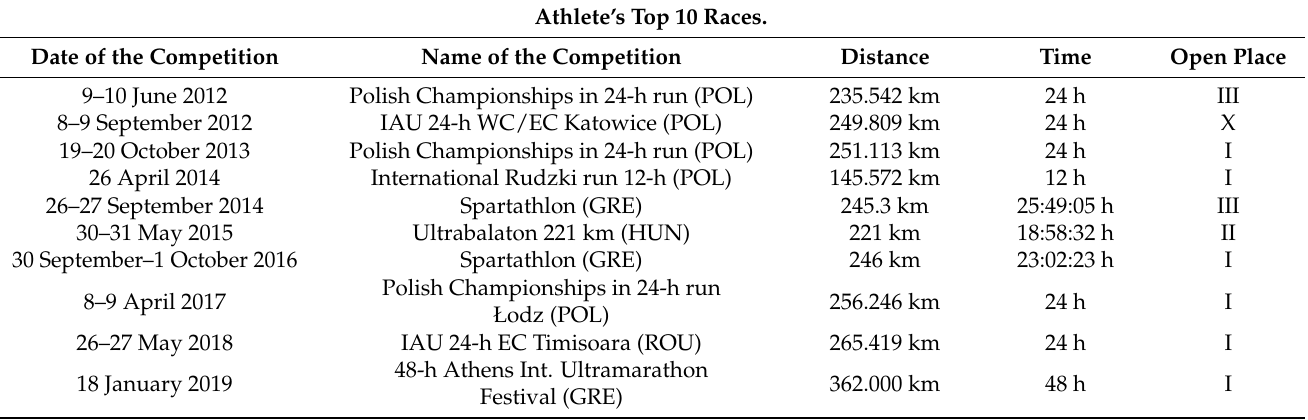
Table 1. Athlete’s top 10 races. Athlete’s Top 10